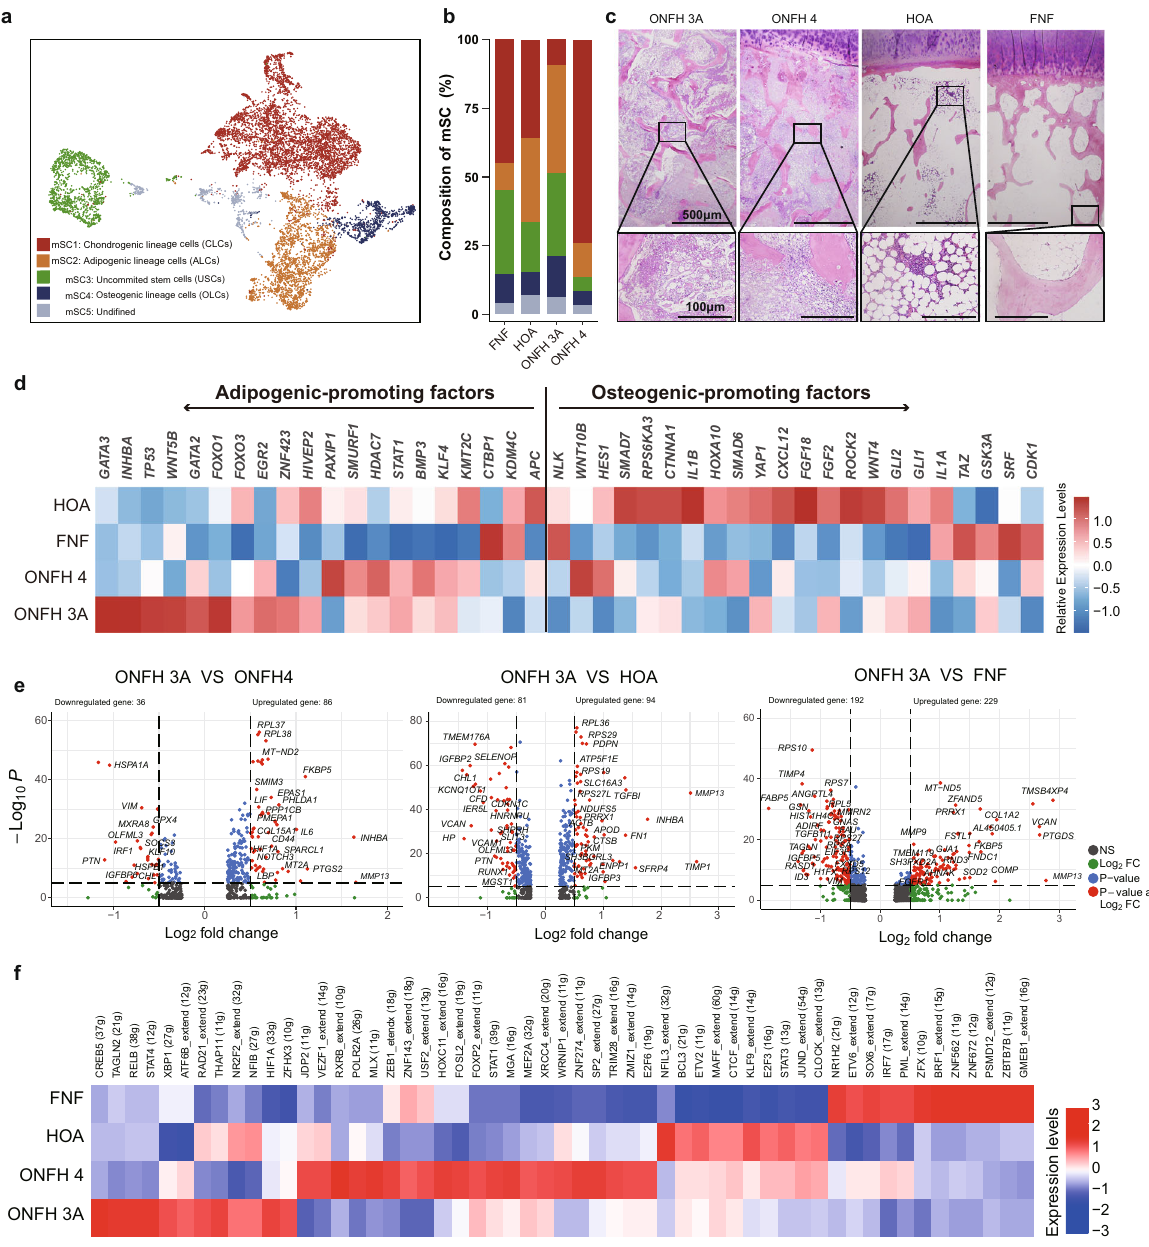
Fig. 3 Diversity of osteogenic- and adipogenic- trends among the ONFH, HOA, and FNF groups. a UMAP showing the clustering of stromal cells integrated by the ONFH (stage 3A and 4), HOA and FNF groups. b Bar plots showing the constituent ratio of each merged stromal cell (mSC) cluster. c Representative haematoxylin and eosin-stained images of femoral head specimens. The lower image is an enlargement of the black box area in the upper image. Scale bar in the upper image = 500 μ m, scale bar in the lower image = 100 μ m. d Heatmap showing the relative expression levels of recognized osteogenic-promoting and adipogenic-promoting factors in the collection composed of USCs, OLCs and ALCs from different groups. e , f DEGs ( P < 0.05, log 2 fold change > 0.5) and regulon relative activity of USCs + OLCs + ALCs from different